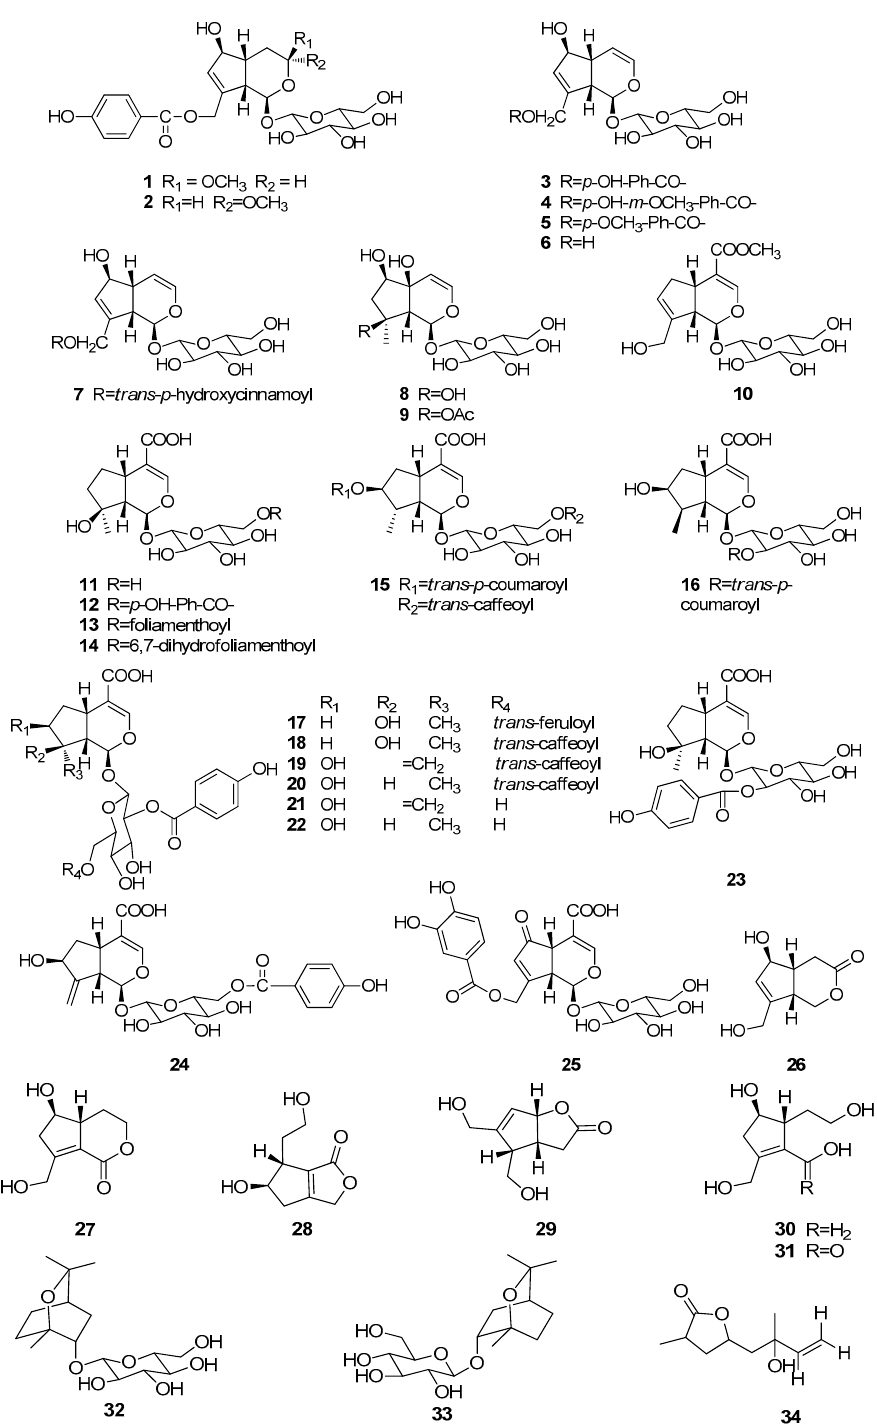
Figure 1. Structures of monoterpenoids 1 – 34 isolated from plants of Vitex L.